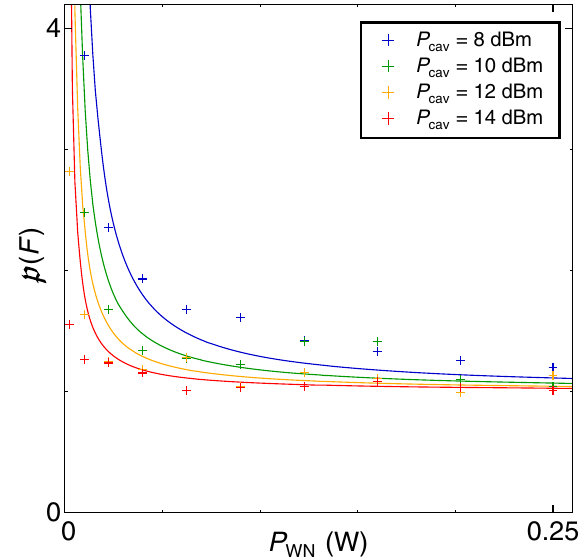
FIG. 4. Precision p ð F Þ of the demodulated signal as a function of mechanical drive power P for different settings of the cavity WN illumination power P . Crosses show precision calculated from cav the voltage record data using Eqs. (4) and (7). The experimental data are consistent with the limiting cases of the theory. Curves show predictions from Eq. (C31). The free parameter α is set by 8 dBm, then held fixed to generate fitting to the data with P cav ¼ the other curves. We separate the data into two figures for cavity drive powers P of 8 – 14 dBm (for powers 16 – 20 dBm, see cav Appendix